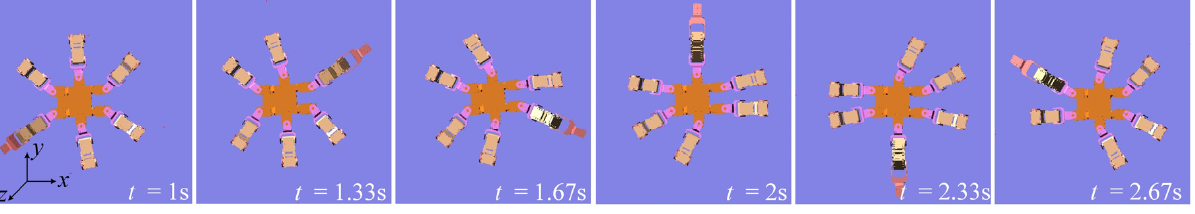
Figure 7. The simulation screenshots of the wave